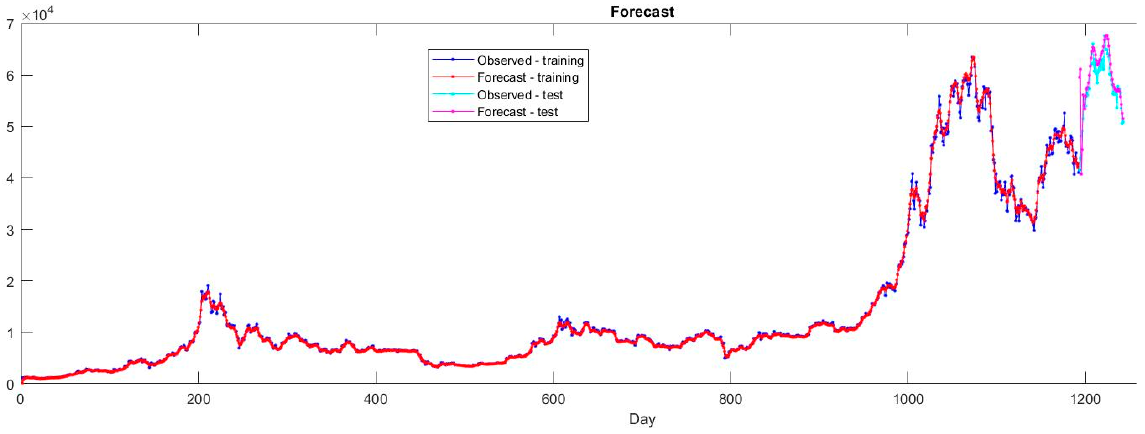
Figure 13. BTC–USD: ES-LSTM training. b. The correlogram analysis of the ETH–USD data is provided in Figure 14. The target variable together with its filtered version are presented in Figure 15.